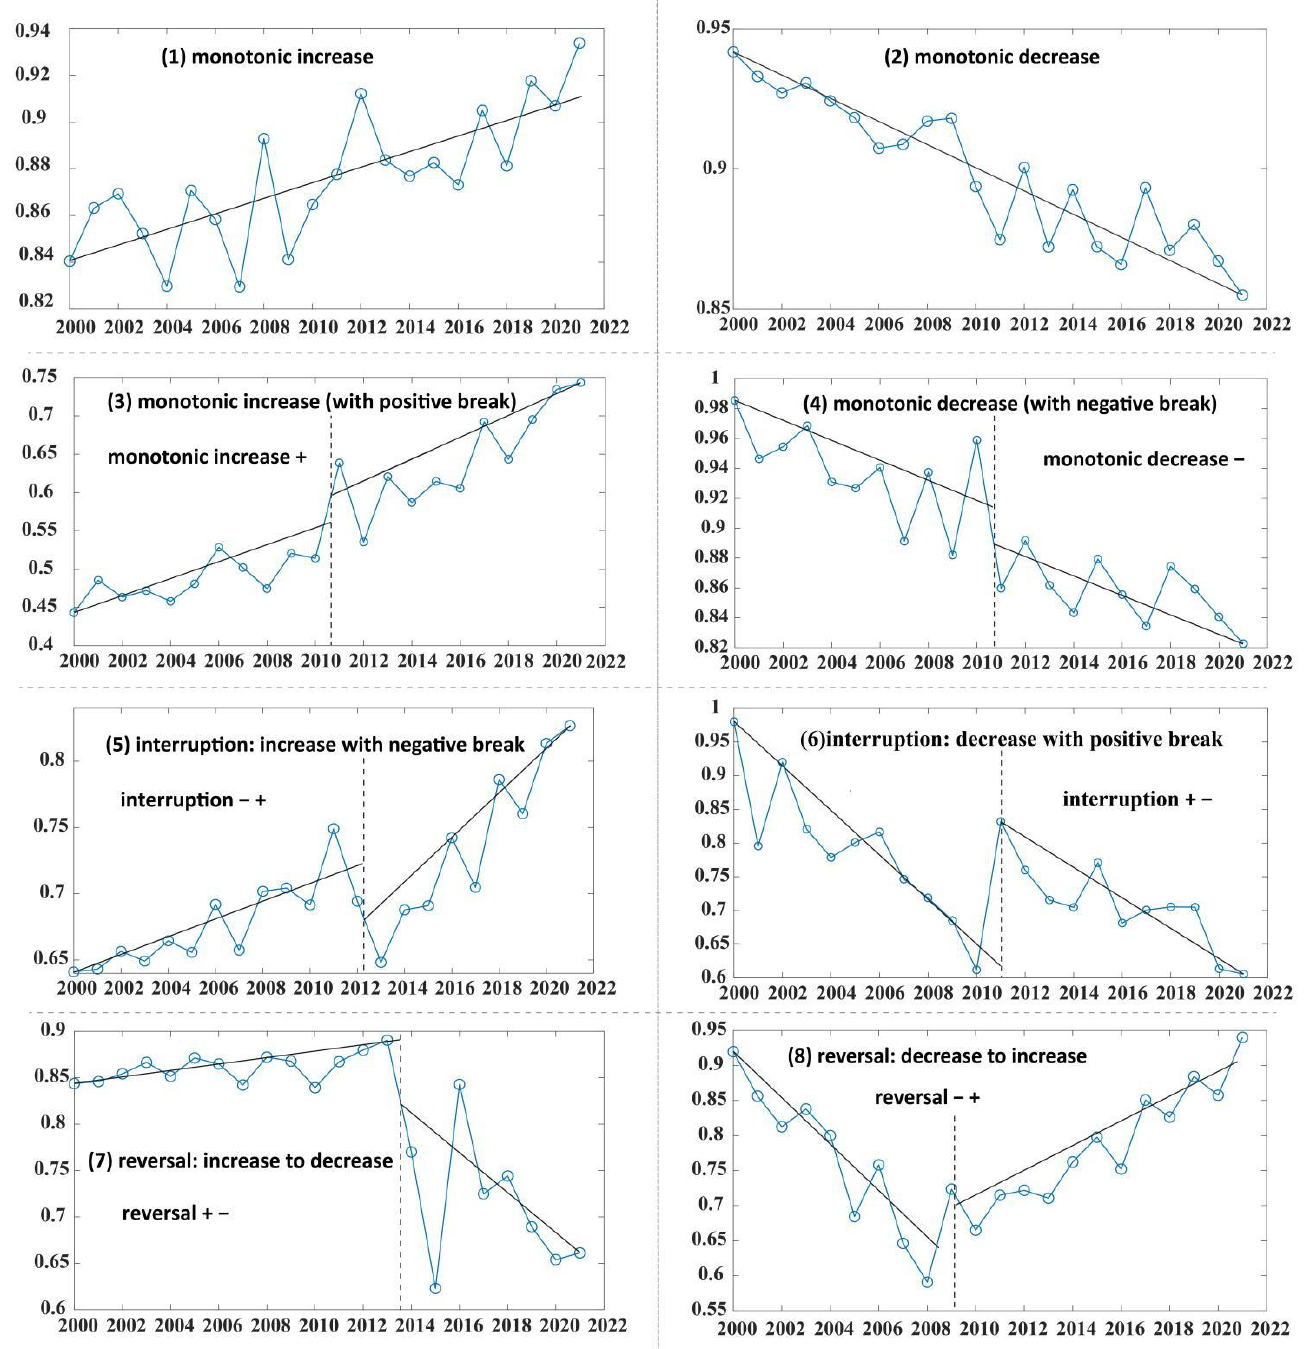
Figure 2. Schematic diagram of BFAST01 trend mutation types . Table 3. Types and meanings of trend mutation in BFAST01 .